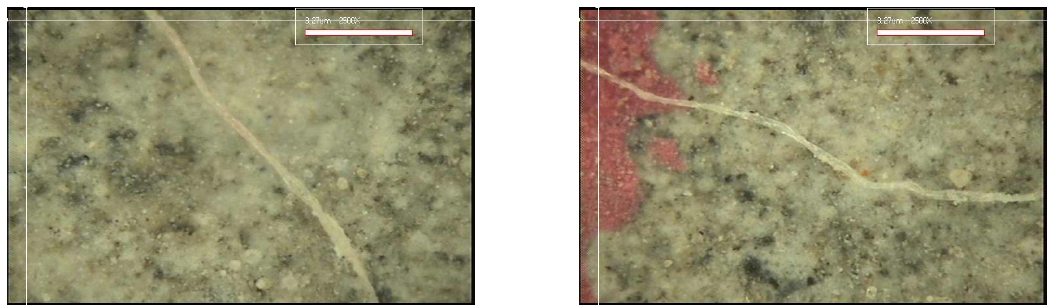
Figure 20. Surface crack monitoring of MCs 5%.